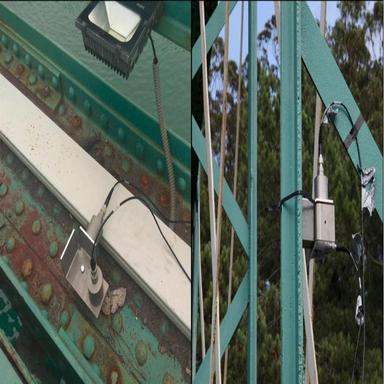
Accelerometers placed on the tie girder and a vertical hanger.